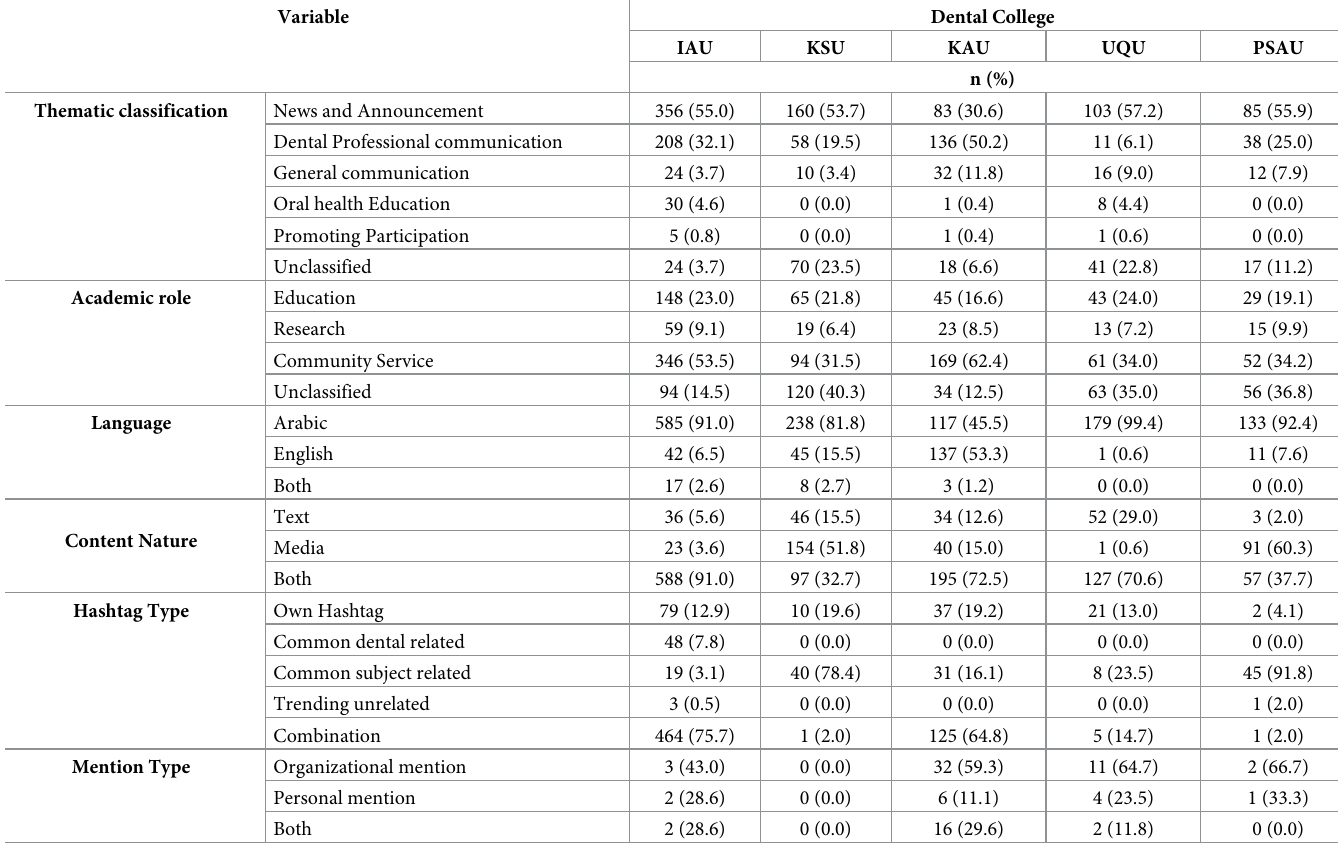
Table 3. Distribution of tweets according to the study variables for the top five dental